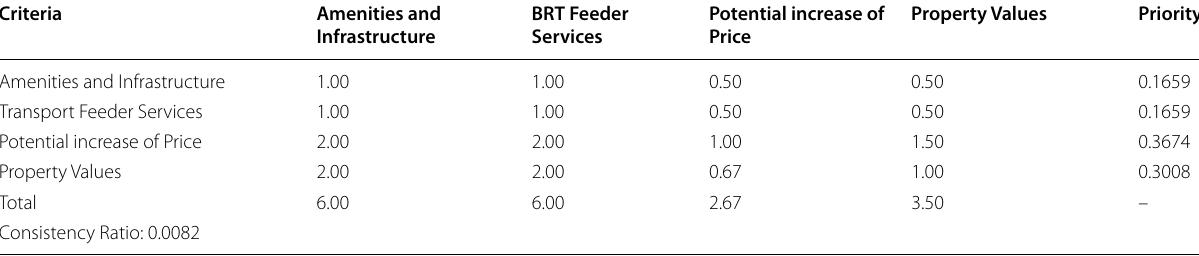
Table 2 Pairwise Comparison Matrix of the used criteria (taking the BRT into consideration) Criteria